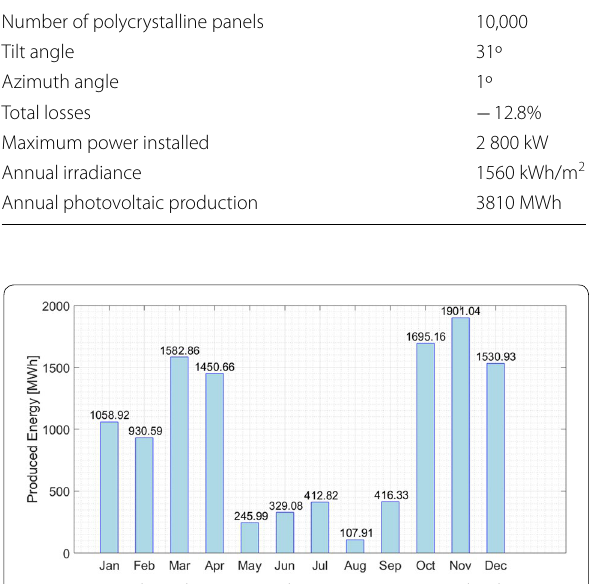
Fig. 12 Annual wind energy production on São Jorge island